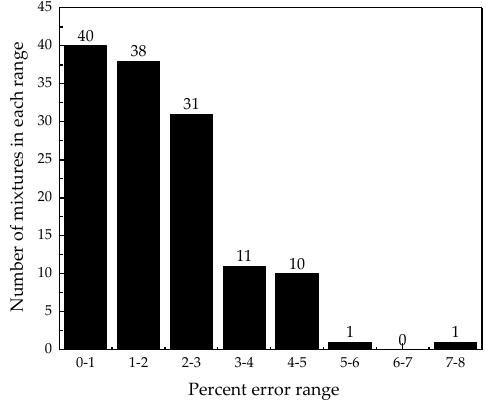
Figure 2. The percent errors obtained by the presented model and the number of mixtures in each range.